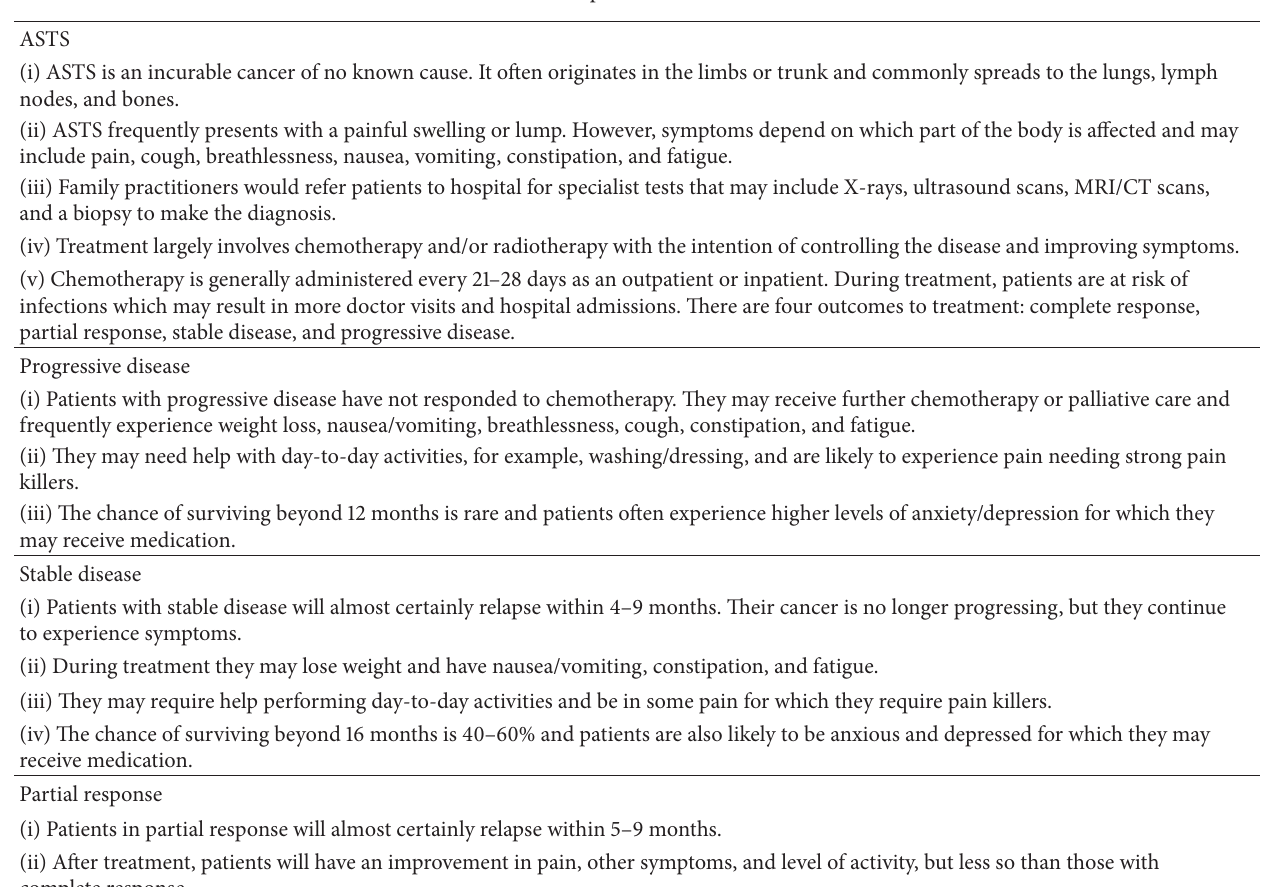
Table 1: Health state descriptions for the four ASTS health